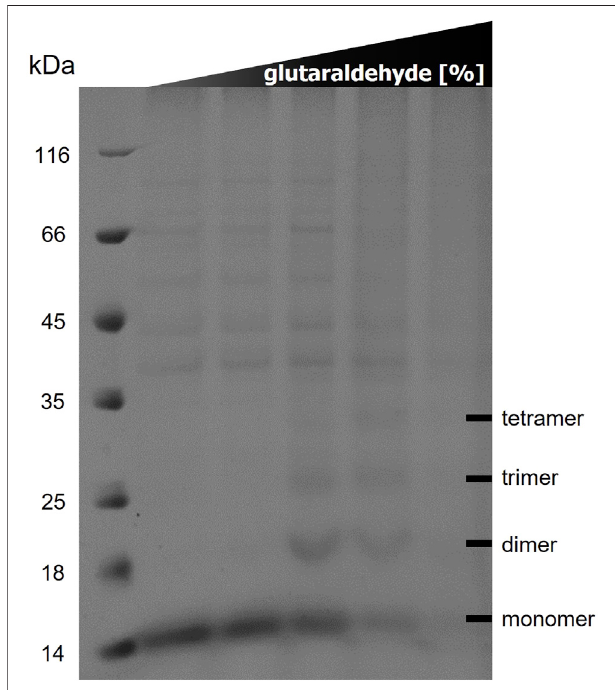
FIGURE 5 | 12% SDS polyacrylamide gel of in vitro cross-linking of TraB 31-110 using increasing glutaraldehyde concentrations (0/0.001/0.01/ 0.05/0.1%) from left to right. Lane 1 shows the MW standard (Thermo Fisher Scienti fi c).